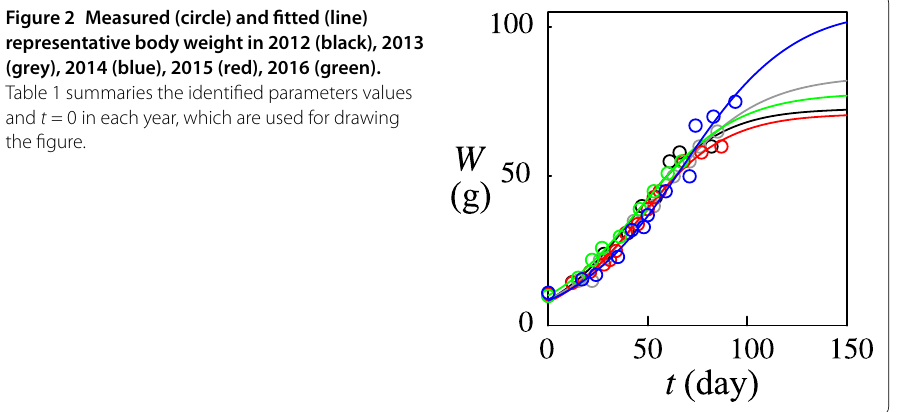
Figure 2 Measured (circle) and fitted (line) representative body weight in 2012 (black), 2013 (grey), 2014 (blue), 2015 (red), 2016 (green). Table 1 summaries the identified parameters values and t = 0 in each year, which are used for drawing the figure.